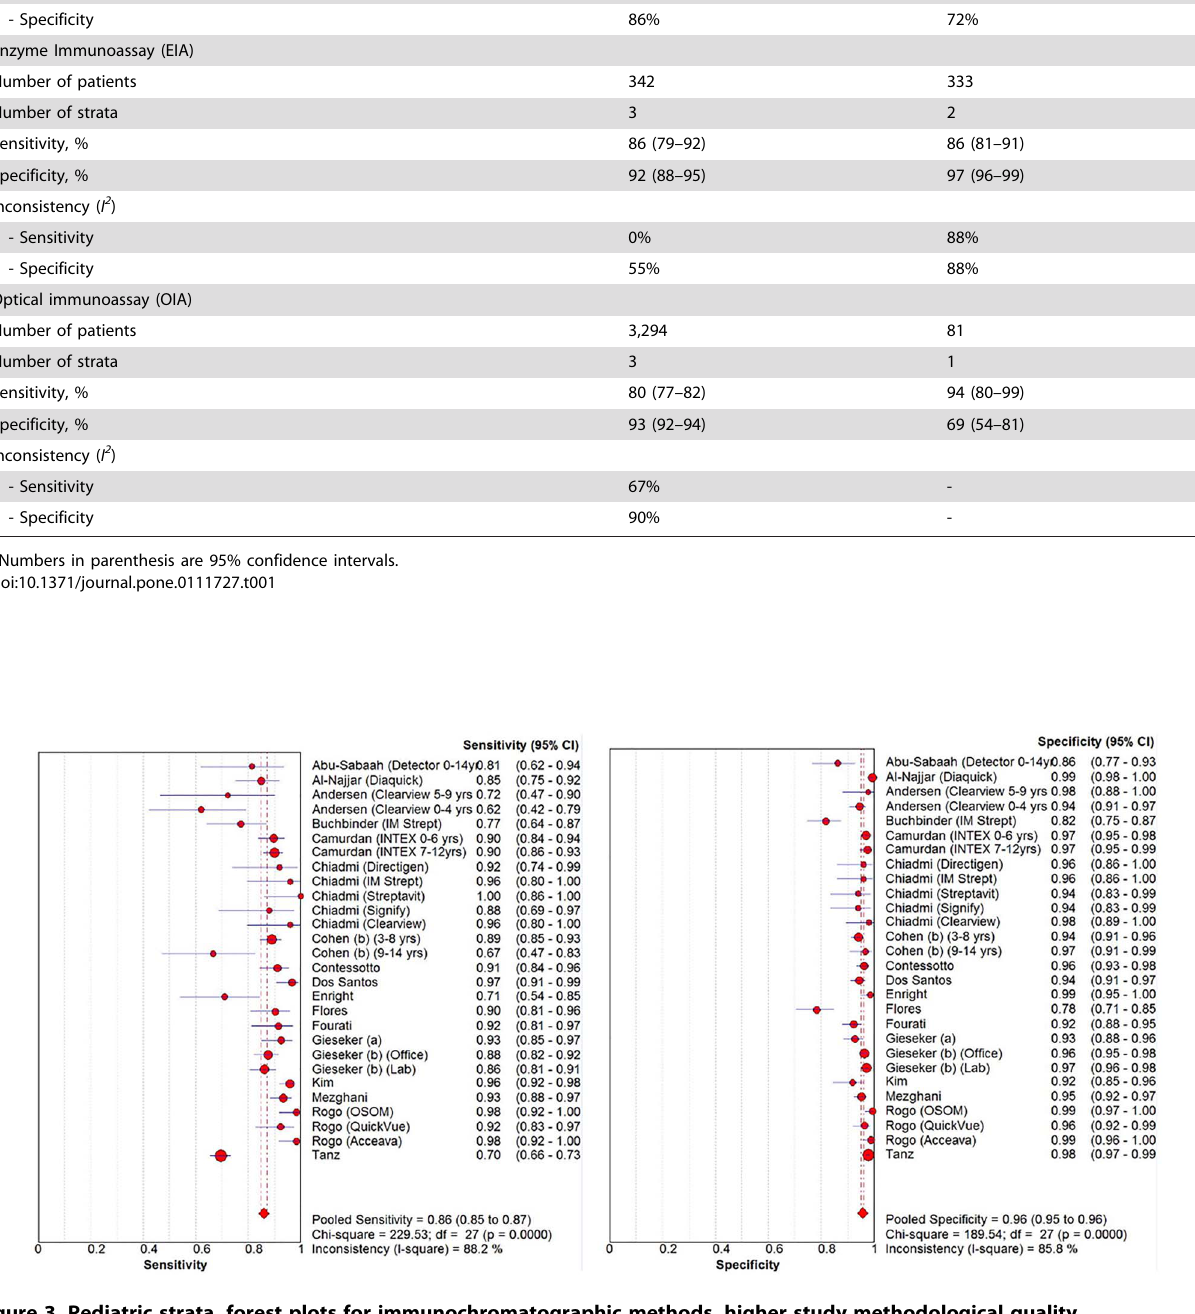
Figure 3. Pediatric strata, forest plots for immunochromatographic methods, higher study methodological quality. doi:10.1371/journal.pone.0111727.g003 PLOS ONE |